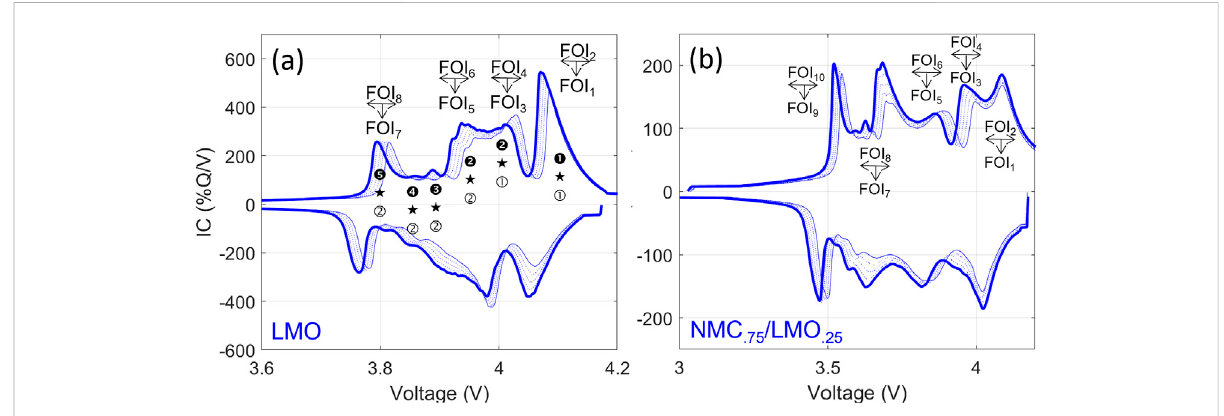
FIGURE 11 Peak evolution from the pristine cell (thick line) to 15% LLI, 10% LAM PE , and 10% LAM NE (thin line) and intermediates (dotted lines) for (A) GIC/ LMO and (B) GIC/(NMC .75, LMO .25 )